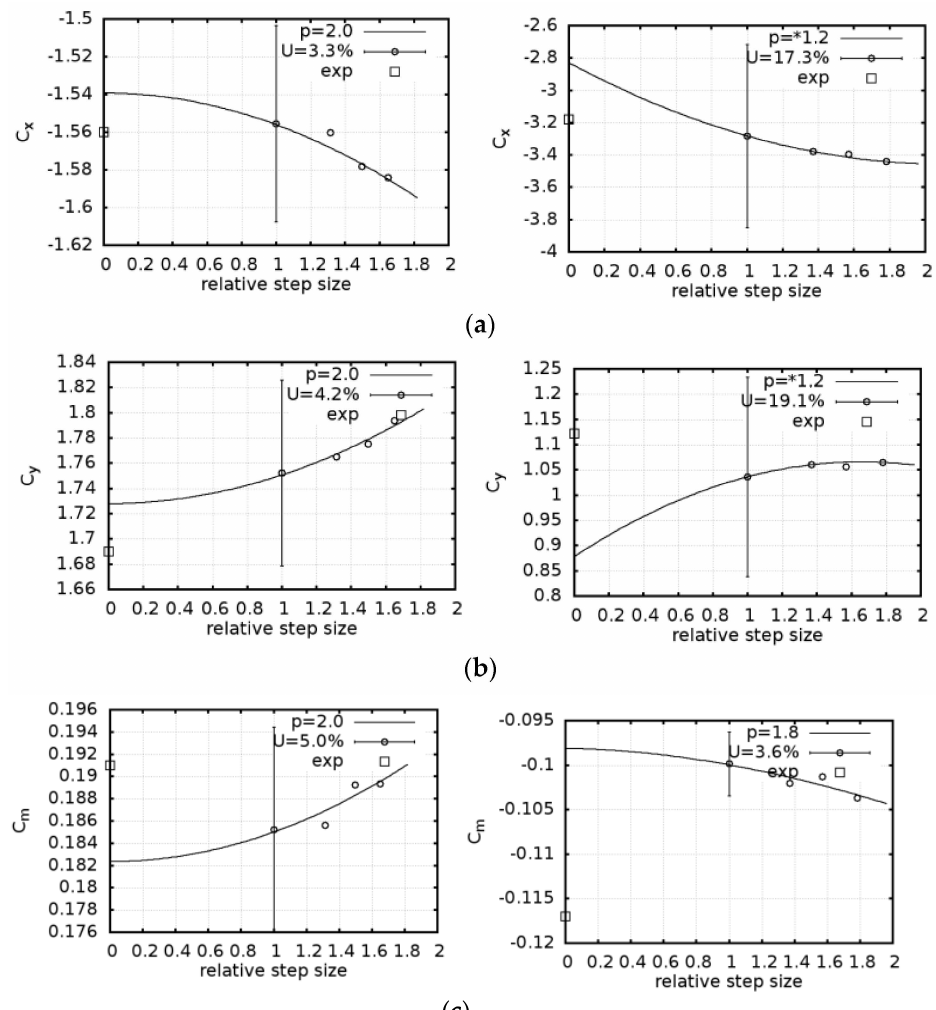
Figure 9. Verification results for FPSO ( left ) and shuttle tanker ( right ). ( a ) C x at 180 ◦ heading; ( b ) C y at 90 ◦ heading; ( c ) C m at 135 ◦ heading.